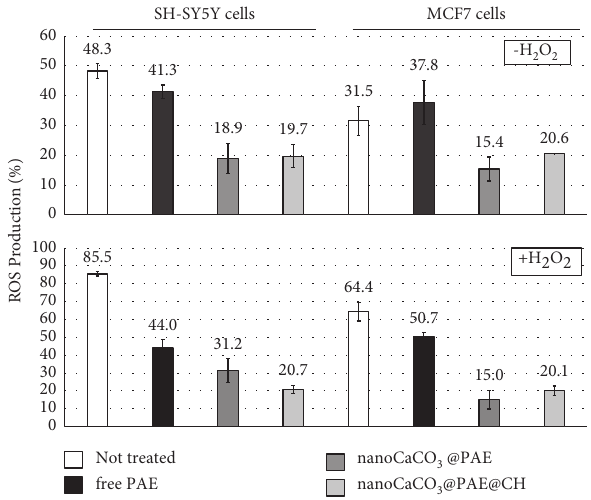
Figure 9: Percentage of ROS production of SH-SY5Y and MCF7 cells after 24h of treatment with PAE, nanoCaCO 3 @PAE, and nanoCaCO 3 @PAE@CH at 0.1mg/ml of extract and without and with previous H 2 O 2 incubation.